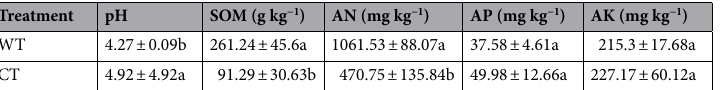
Table1. Chemical properties of sampled soils under cultivated conditions (CT) and wild growth conditions (WT). Values are means ± Standard error (S.E) Values within the same column followed different letters mean differences significant at 0.05 or 0.01 level. SOM = Soil organic matter, AN = Available nitrogen, AP = Available phosphate, AK = Available potassium; CT = cultivated conditions, WT = wild condition